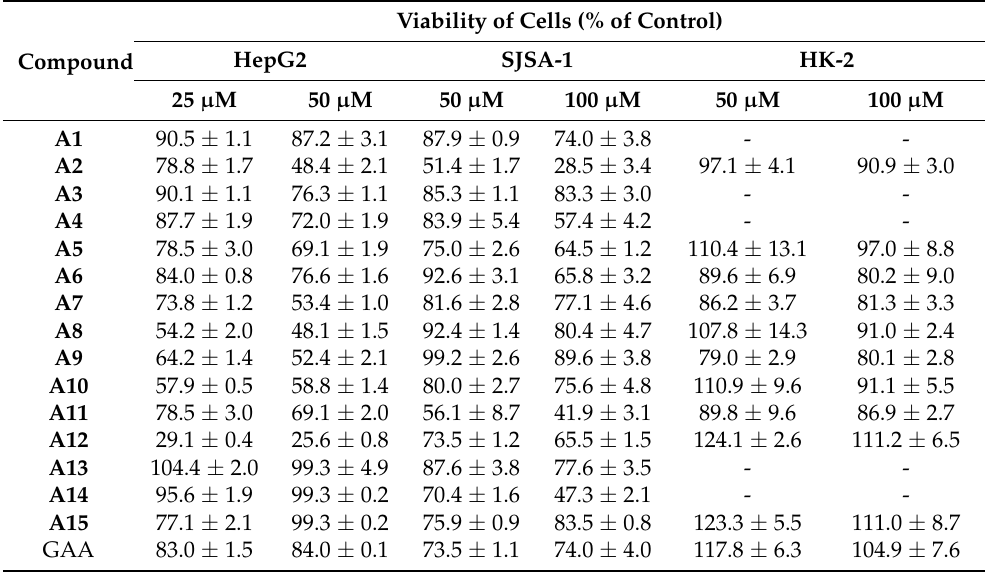
Table 2. The viability of HepG2, SJSA-1, HK-2 cells at different concentration. Mean values ± SD from three independent experiments ( n = 3) performed in duplicate are